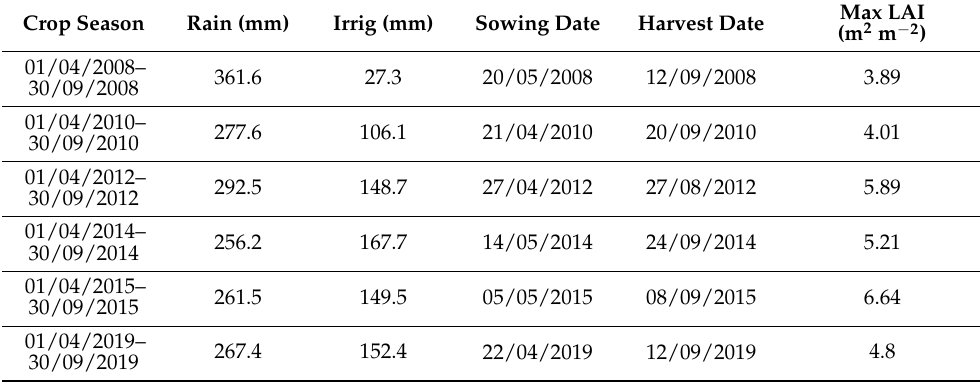
Table 1. Maize crop cycles, total amount of rainfall and irrigation, sowing and harvest dates, maximum Leaf Area Index